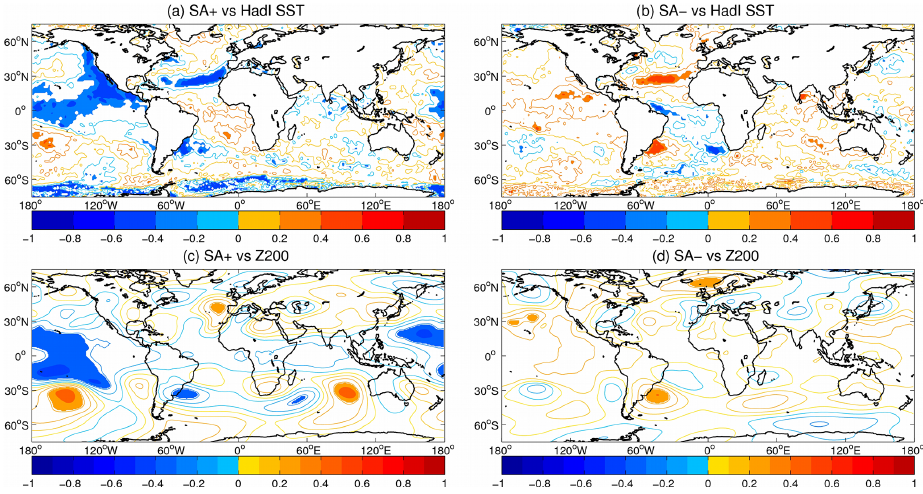
Figure 13. Interannual correlation over the period 1981–2020: SA + and SA − frequency from the ERA5 classification vs. (a, b) HadISST and (c, d) ERA5 geopotential height at 200hPa in ASO. Shading displays significant correlations at the 95% level of confidence. Time series are detrended and